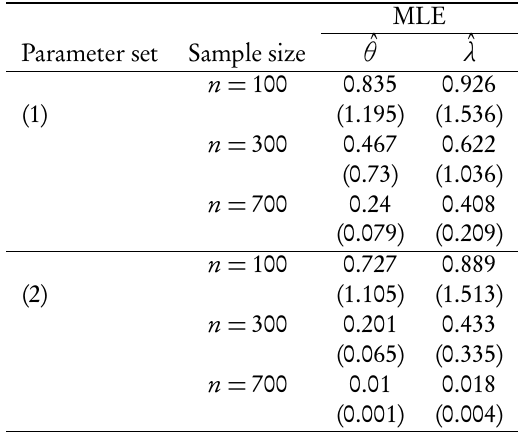
Absolute bias and standard errors (given in parenthesis) of each estimators of the PHP distribution obtained by the method of maximum likelihood in case of parameter sets 1 and